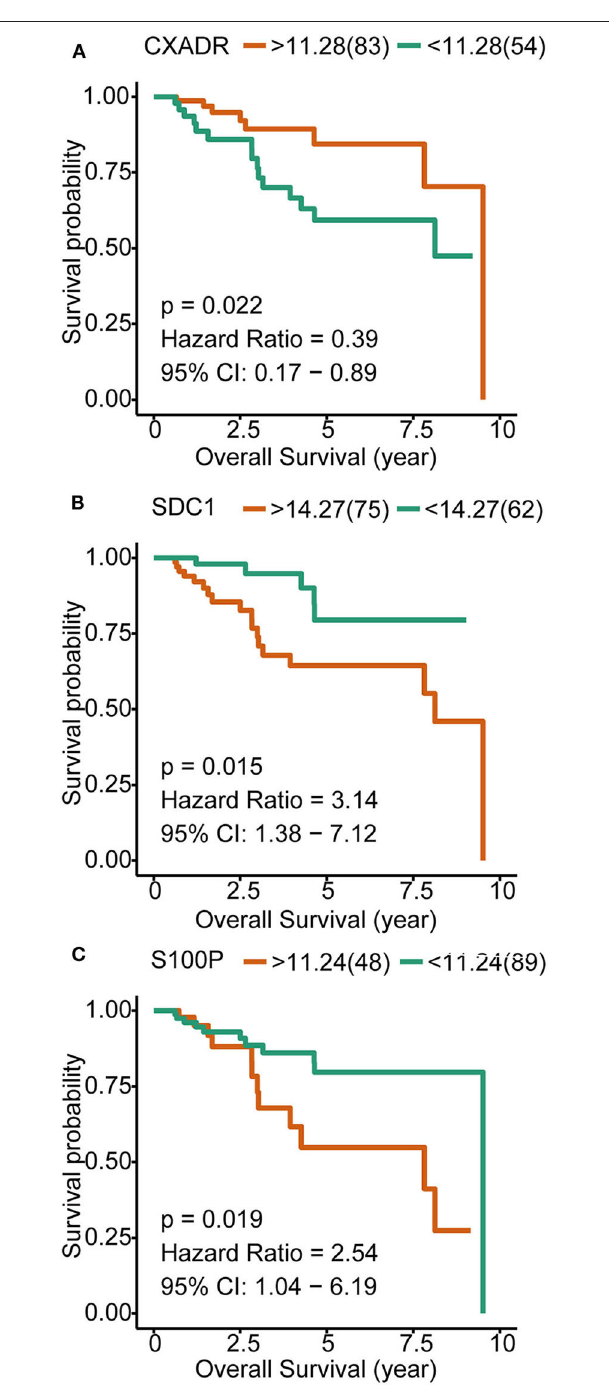
FIGURE 4 | Kaplan–Meier overall survival analyses for the three overlapping genes expressed in triple-negative breast cancer (TNBC) patients. (A) Influence of CXADR on OS of TNBC patients. (B) Influence of SDC1 on OS of TNBC patients. (C) Influence of S100P on OS of TNBC patients.